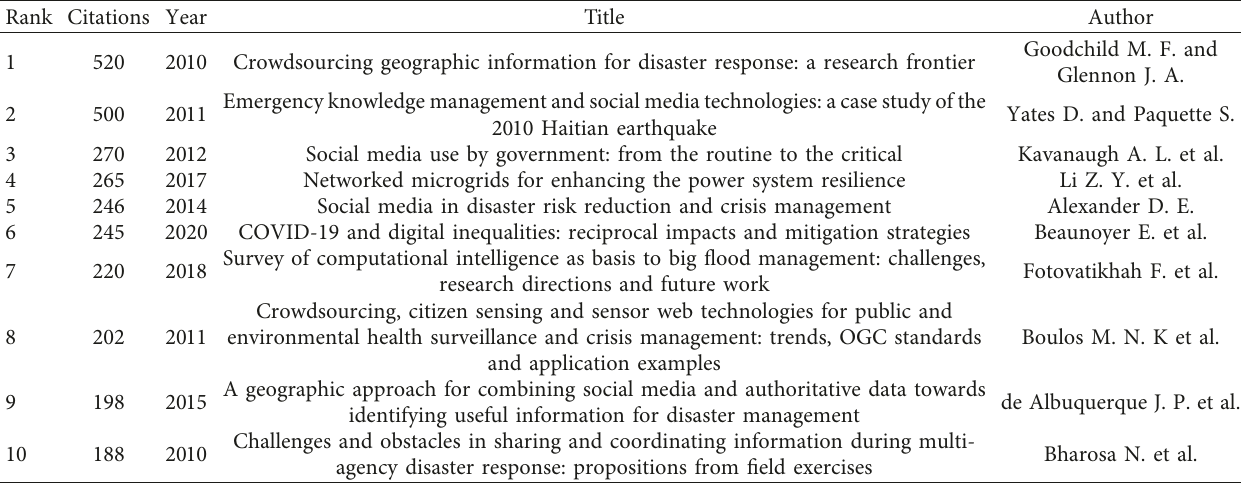
Table 1: Top 10 highly cited references of international DEM research.